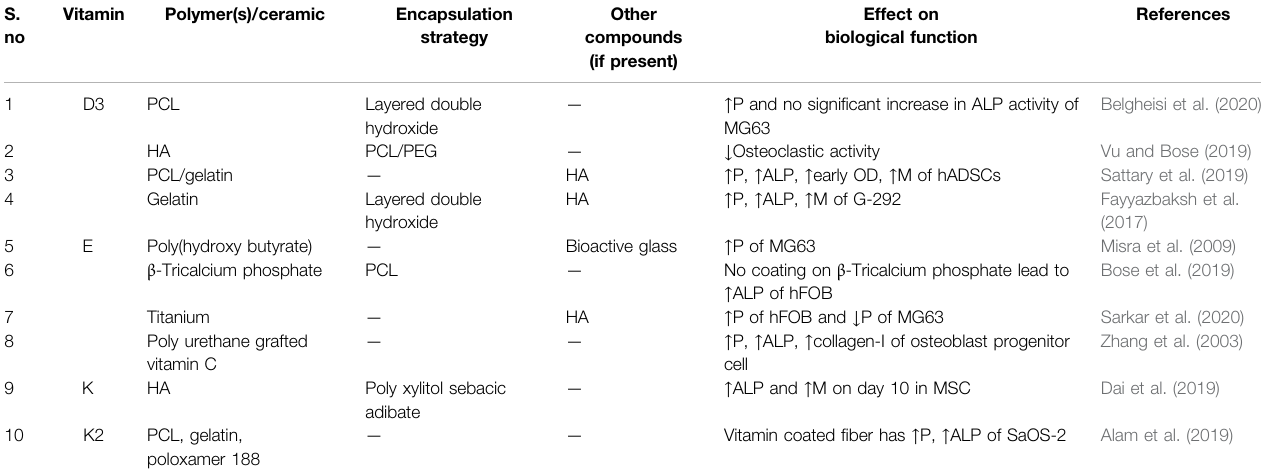
TABLE 2 | Effect of vitamins towards osteoblast's